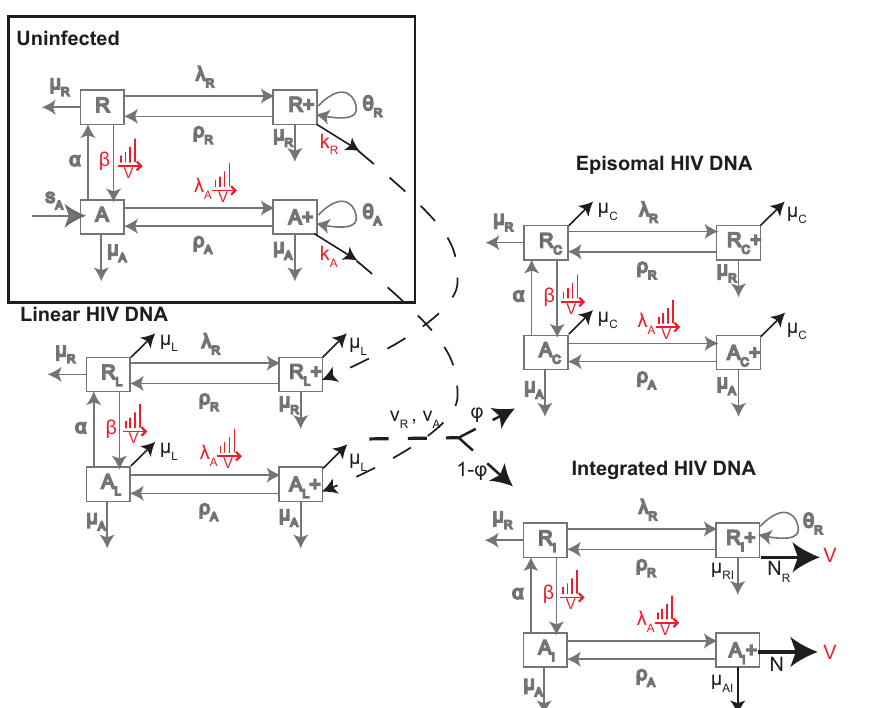
Fig 2. Uninfected Homeostasis : Mechanismscontrolling resting non-dividing R and dividing R + , activated non-dividing A and dividing A + memory CD4+ T cells numbers. Dividingcells R + , A + arise at rates λ R , λ A and can go through severalrounds of proliferation giving rise to θ R and θ A copies, which can then revert to non-dividingstates at rates ρ R , ρ A . Activated non-dividingcells arise from activated na ï vecells at rate s A and from activationof resting, non-dividingcells R at rate β . Activated non-dividing cells revert to a resting state at rate α . Resting and activated cells die at rates μ R , μ A . HIV DNA infectionof memory CD4+ T cells : The model duplicatesthe uninfectednetwork for each of the cells containing linear, episomaland integratedHIV DNA. Modifications to the uninfectednetwork to describedynamicsof HIV are highlightedin black. Infection of the uninfectedsubsets leads initiallyto cells with linear HIV DNA (subscript L), then either episomal(subscript C) or integrated HIV DNA (subscript I). All parameters are the same across each of these networks. The additional parameters relate to the loss of linear and episomalHIV DNA within cells at rates μ L , μ C respectively, progressionof linear at rate ν A , ν R in activated and resting cells respectivelywhich convert to episomalHIV DNA with probability ϕ or integratedHIV DNA with probability1- ϕ , a higherdeath rate of productively infected cells ( A I+ ) at rate μ AI , and the rate of productionof virions from these cells N per day. We also assume dividingresting cells with integratedHIV DNA can producevirions at rate N R and die at rate μ RI .